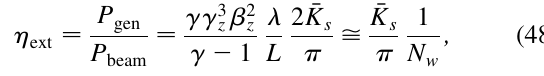
[Eq. (44)] as a function of initial detuning 4 (cid:27) (cid:3) 0 (cid:4) for a prebunched FEL (a) and a (cid:27) , corresponding in (cid:27)